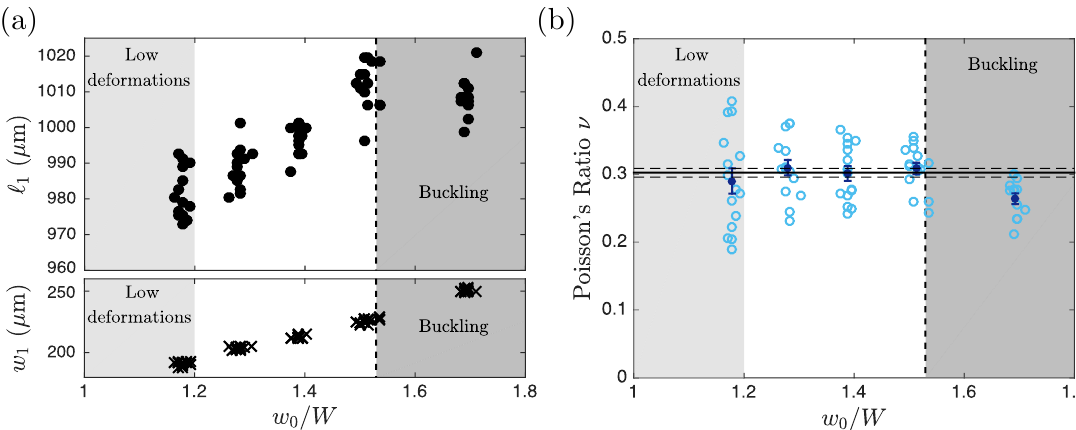
Figure 3. Direct measurements of particle length and width and the derivation of Poisson’s ratio. Results are shown for the hydrogel PW 30 in a channel of width W = 175 ± 0.7 µ m and height H = 103 ± 3 µ m. The initial particle length was kept constant l 0 = 960 ± 8 µ m while the confinement w 0 / W was increased. ( a ) Length (top) and width (bottom) of the deformed particle at equilibrium as a function of the confinement w 0 / W . ( b ) Evolution of Poisson’s ratio as a function of w 0 / W . In ( a , b ) the light (dark) gray regions correspond to particle widths that are too small (large) to ensure good precision of the determination of Poisson’s ratio. The vertical dotted line corresponds to the buckling threshold (see text). In ( b ) each light-blue circle corresponds to a single experimental measurement, and dark blue markers correspond to their average and standard deviation σ normalized by n = 15 independent measurements. The horizontal black lines correspond to the average (solid line) and standard deviation (dashed line) of all points except from the dark gray region ( w 0 / w 1 ≥ 1.53 ). Poisson’s ratio was found to be ν 30% = 0.302 ± 0.007 for the photosensitive solution PW 30